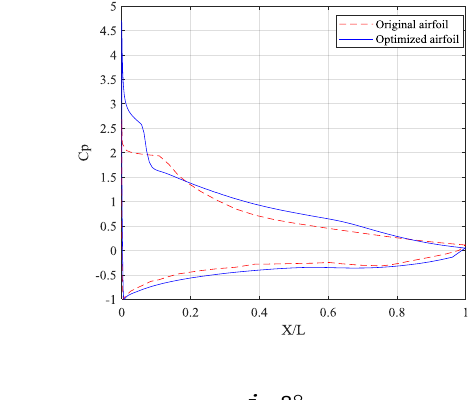
Figure 16. Surface pressure distributions.